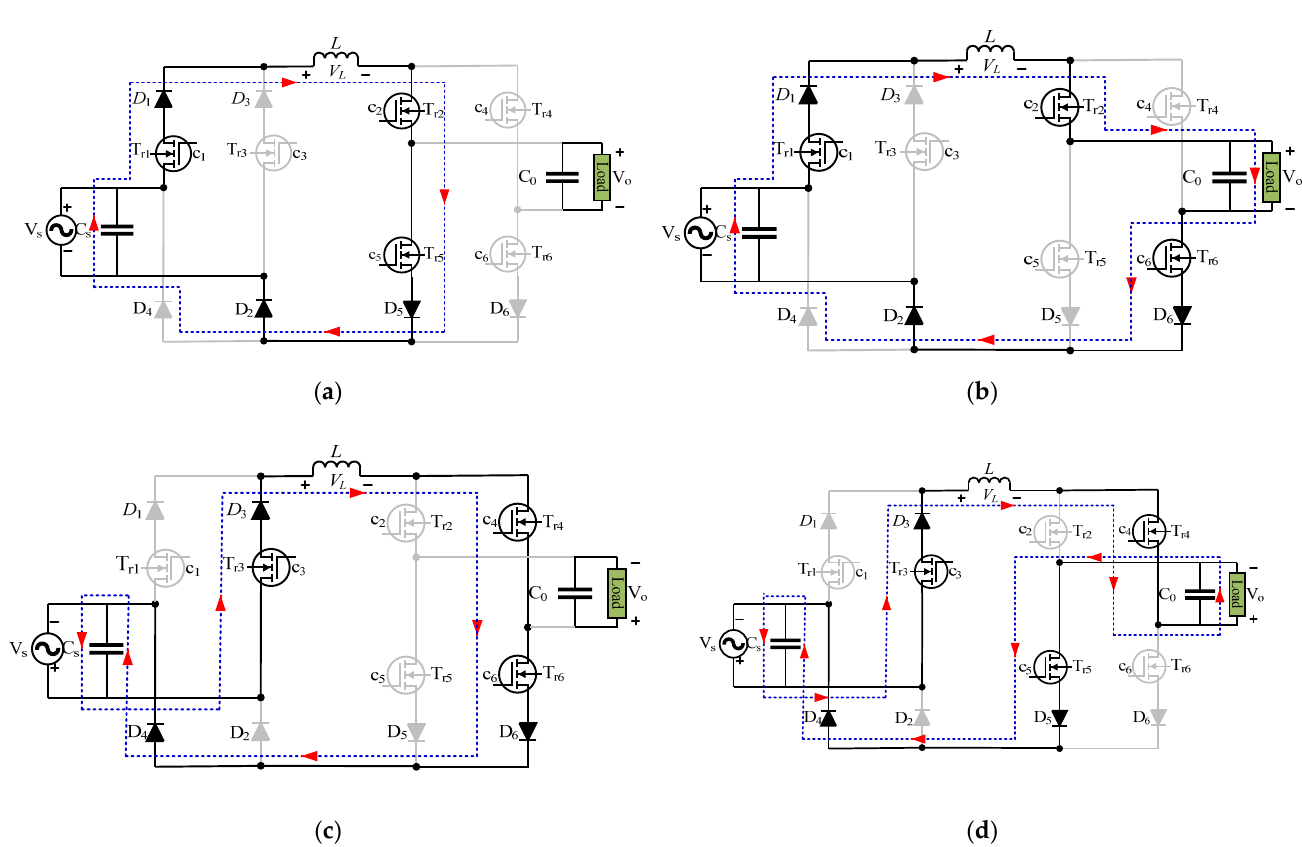
Figure 7. Equivalent power transfer loops formed by PWM control to have non-inverted voltage boost output for half cycles of ( a ) and ( b ) positive source voltage; ( c ) and ( d ) negative source voltage.